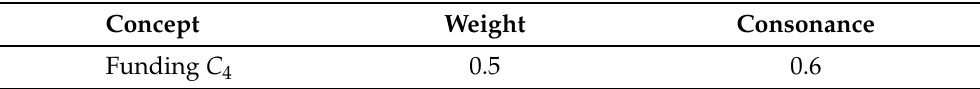
Table 12. Targeted concept changes in the fuzzy cognitive map determining the work of a banking system.